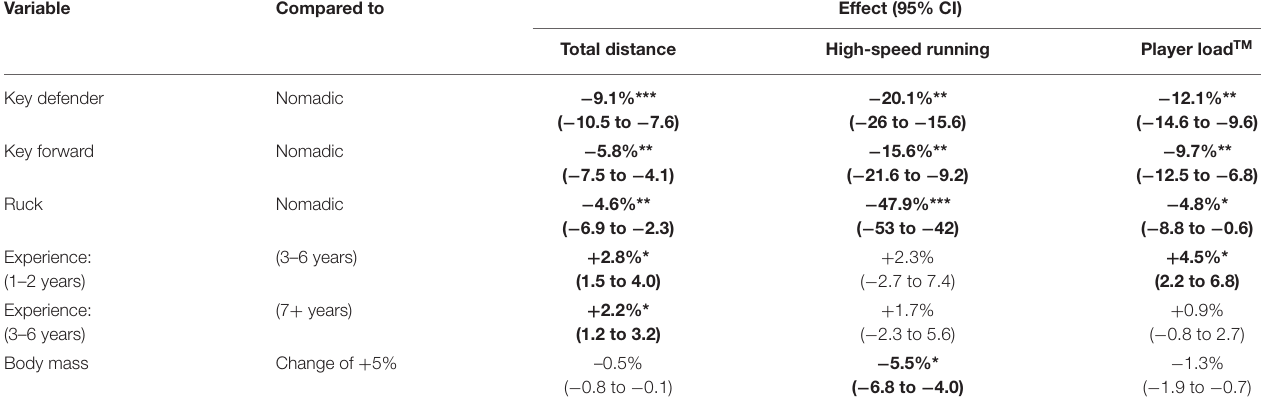
TABLE 6 | The effects of position, experience, and body